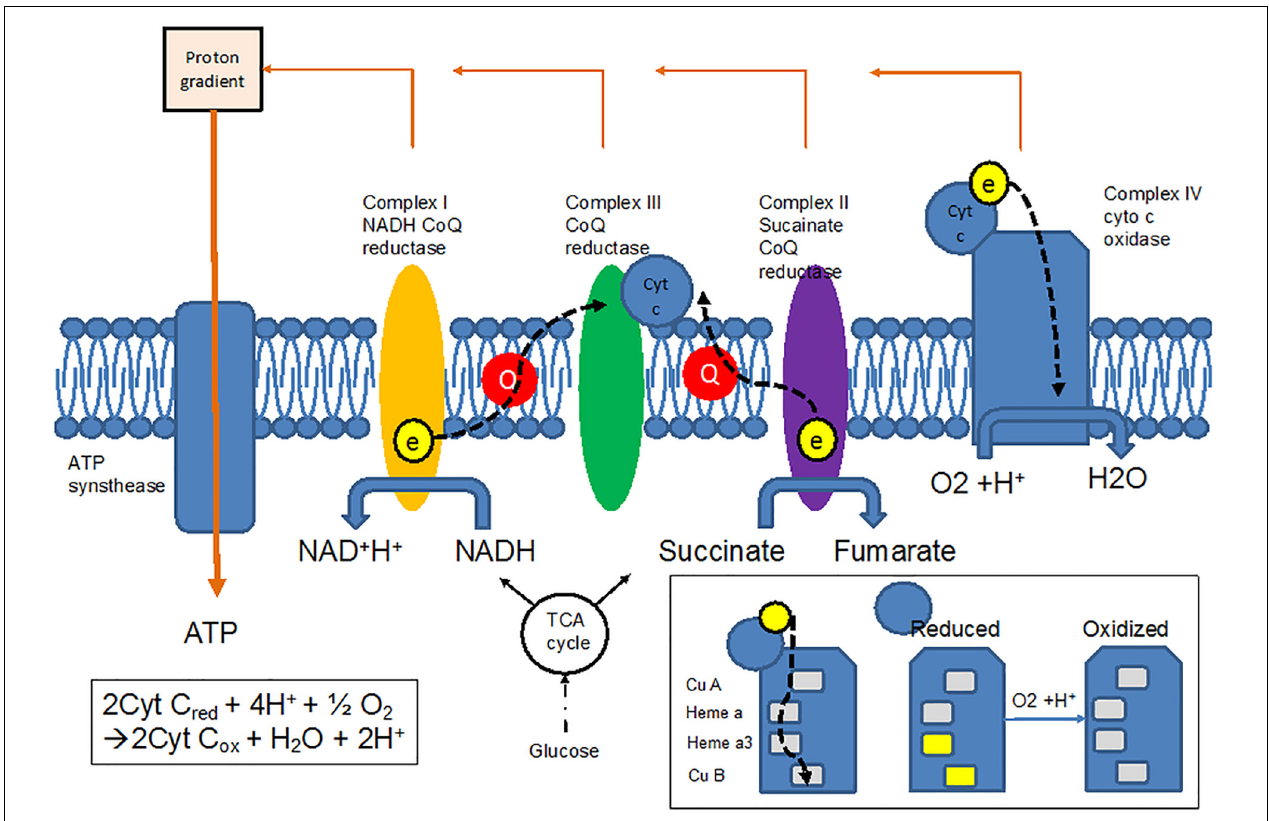
FIGURE 3 | Electron transfer chain allows electrons to be transferred from the TCA cycle to oxygen via cytochrome c oxidase (CCO), resulting in changes in the redox states of